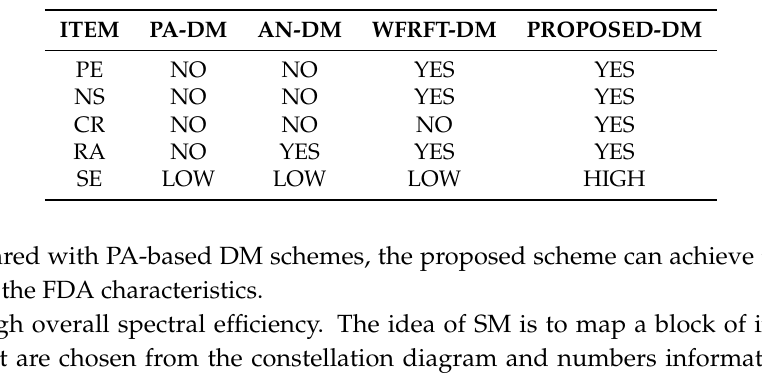
Table 2. Comparisons for different